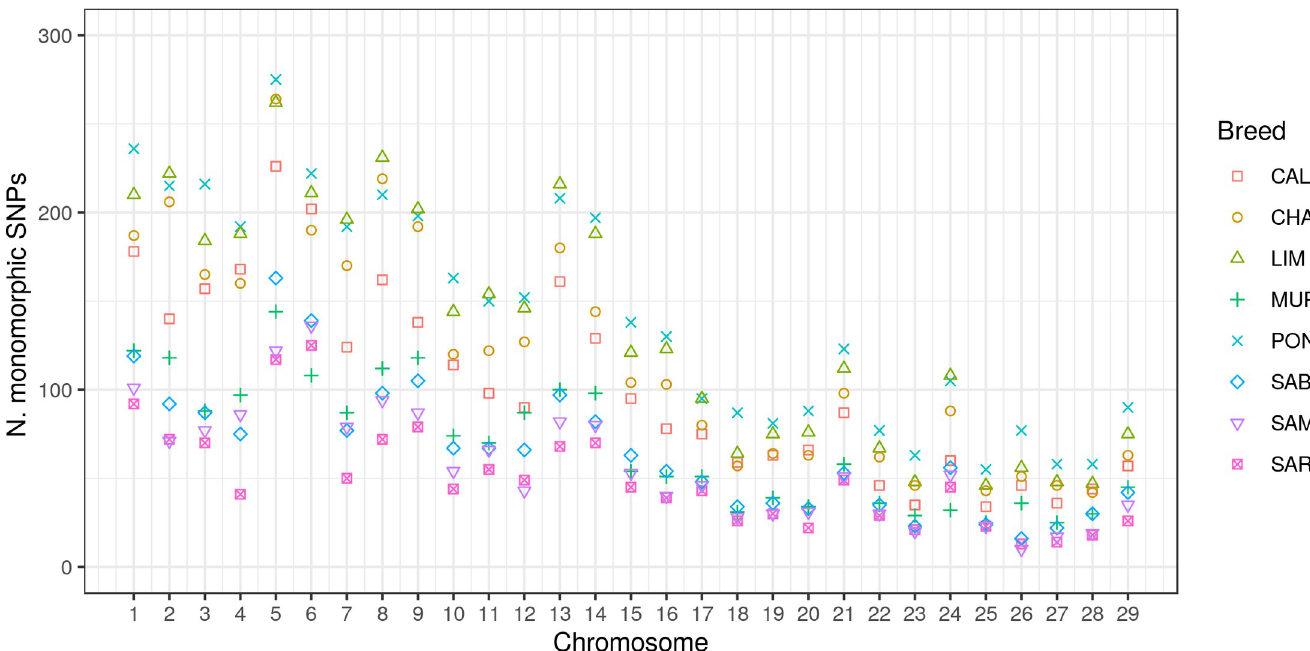
Fig 2. Monomorphic single nucleotide polymorphisms distribution across chromosomes in each breed 1 , where 1 CAL = Calvana; CHA = Charolais; LIM = Limousine; MUP = Mucca Pisana; PON = Pontremolese; SAB = Sardo Bruna; SAM = Sardo Modicana; SAR = Sarda.